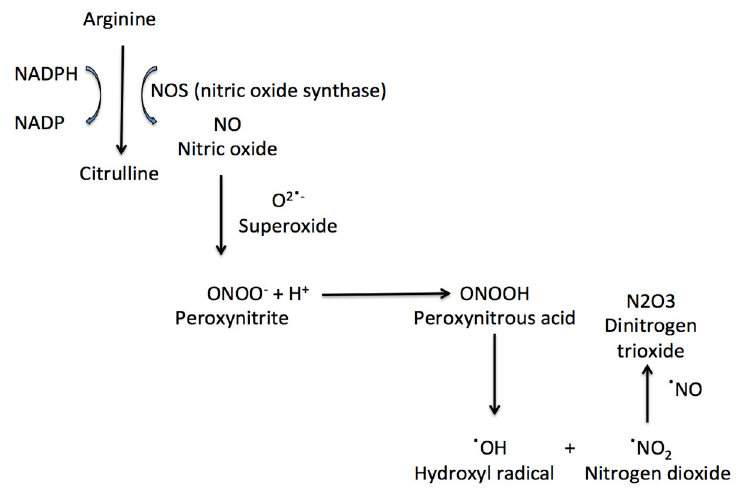
Figure 1. The synthesis of nitric oxide and some important nitrosative species.